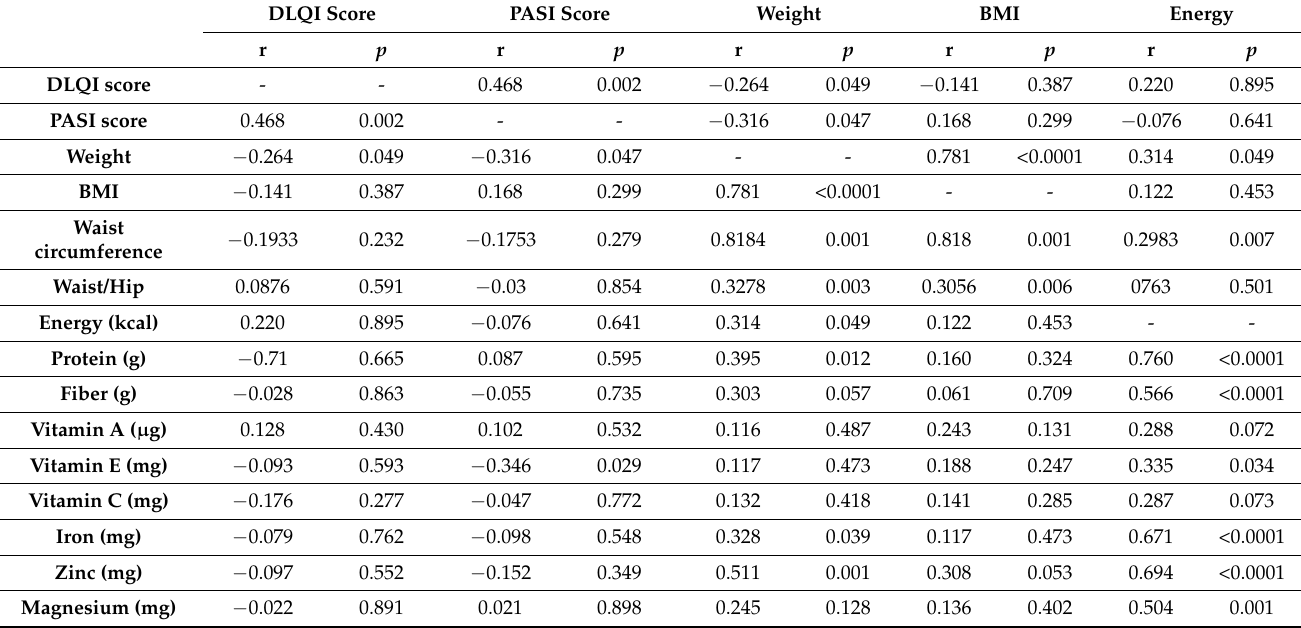
Table 3. The relationship between DLQI, PASI scores and anthropometric measurements, energy and nutrient intake of patients with psoriasis. DLQI Score PASI Score Weight BMI